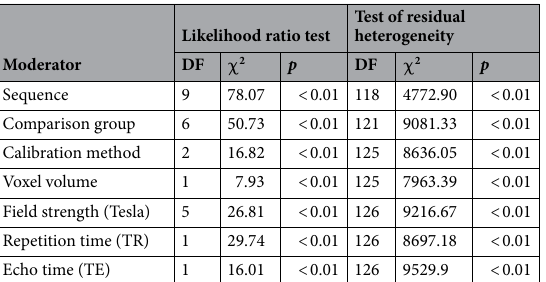
Table 2. Tests comparing models including each methodological moderator to a reduced model. DF degrees of